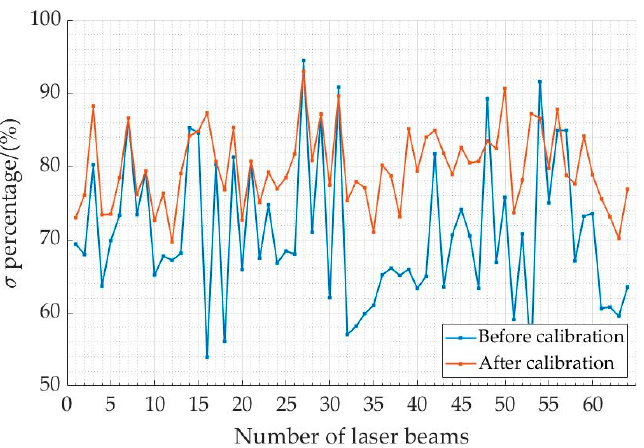
Figure 12. The percentage of points within the σ confidence interval for the distance standard deviation from the point to the calibration plane.